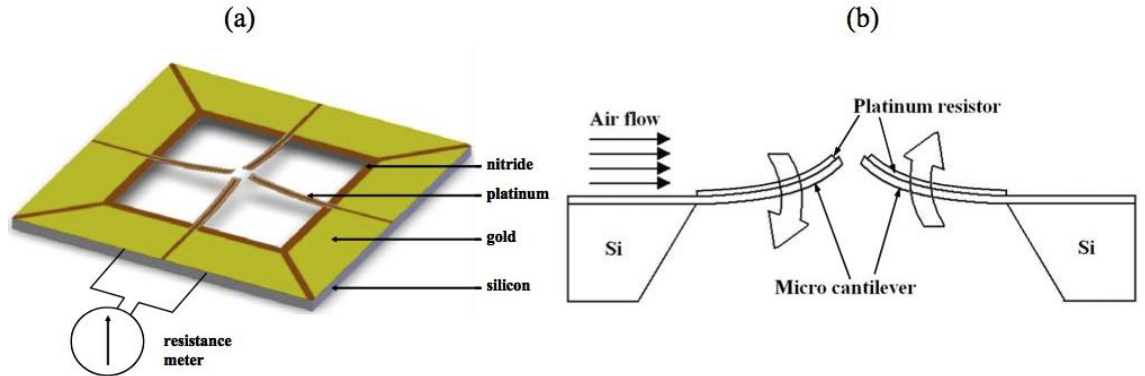
Figure 8. Diagram of flow device with integrated thermoresistors for thermal flow sensing and cantilevers for dual mode flow sensing; flow speed is thermally sensed and flow direction is physically sensed by cantilever deflection